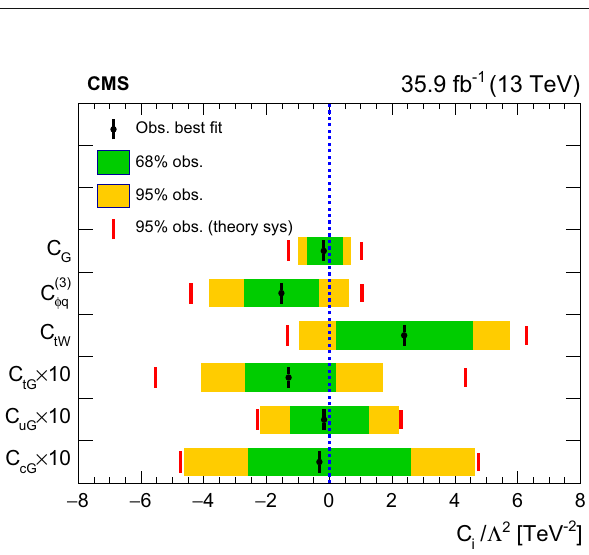
Fig. 6 Observed best fits together with one and two standard deviation bounds on the top quark effective couplings. The dashed line shows the SM expectation and the vertical lines indicate the 95%CL bounds including the theoretical